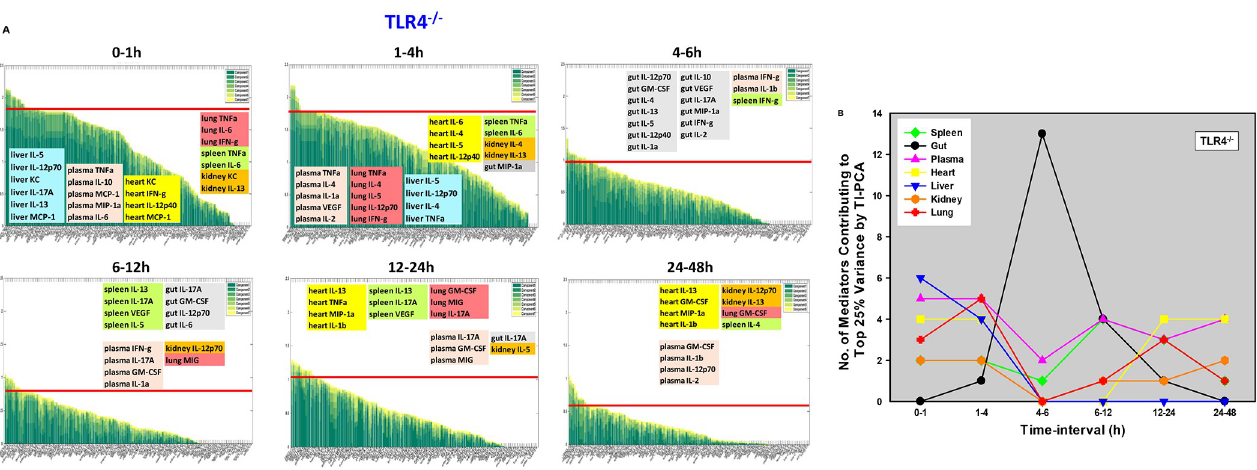
Fig 3. Analysis of endotoxemic TLR4 -/- mice by Time-Interval PCA (TI-PCA). Animals (n = 4 for each experimental group) were injected with LPS (3 mg/ kg, i.p.). At different time points upon sacrifice, the inflammatory mediators in blood and different organs were measured by Luminex, and identification ( A ) as well as quantification ( B ) of the inflammatory mediators contributing to the top 25% variance of the inflammatory response was performed as described in Fig 2